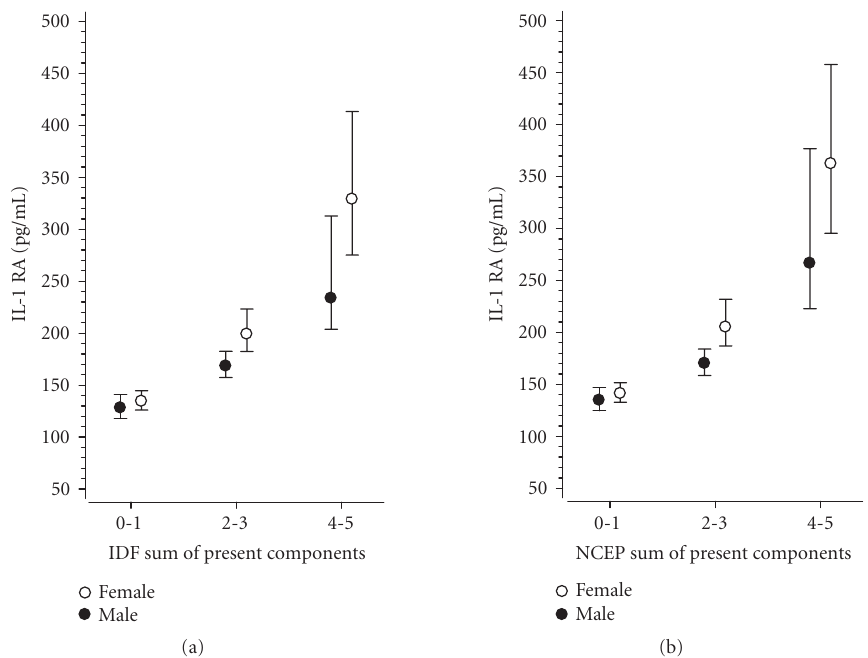
Figure 3: Relationship between interleukin-1 receptor antagonist (IL-1Ra) and the number of components of the metabolic syndrome according to the IDF and NCEP criteria (95% confidence interval obtained by bias-corrected and accelerated bootstrapping (5000 replica-